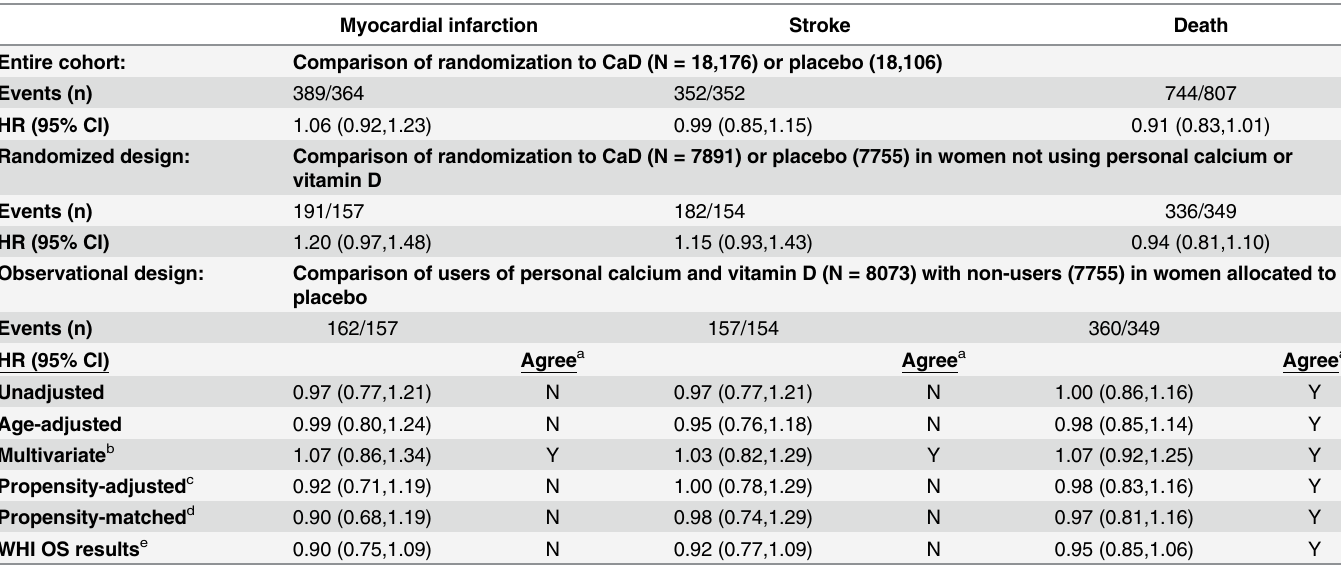
Table 2. Comparison of results from the randomized and observational designs for cardiovascular events. Myocardial infarction Stroke